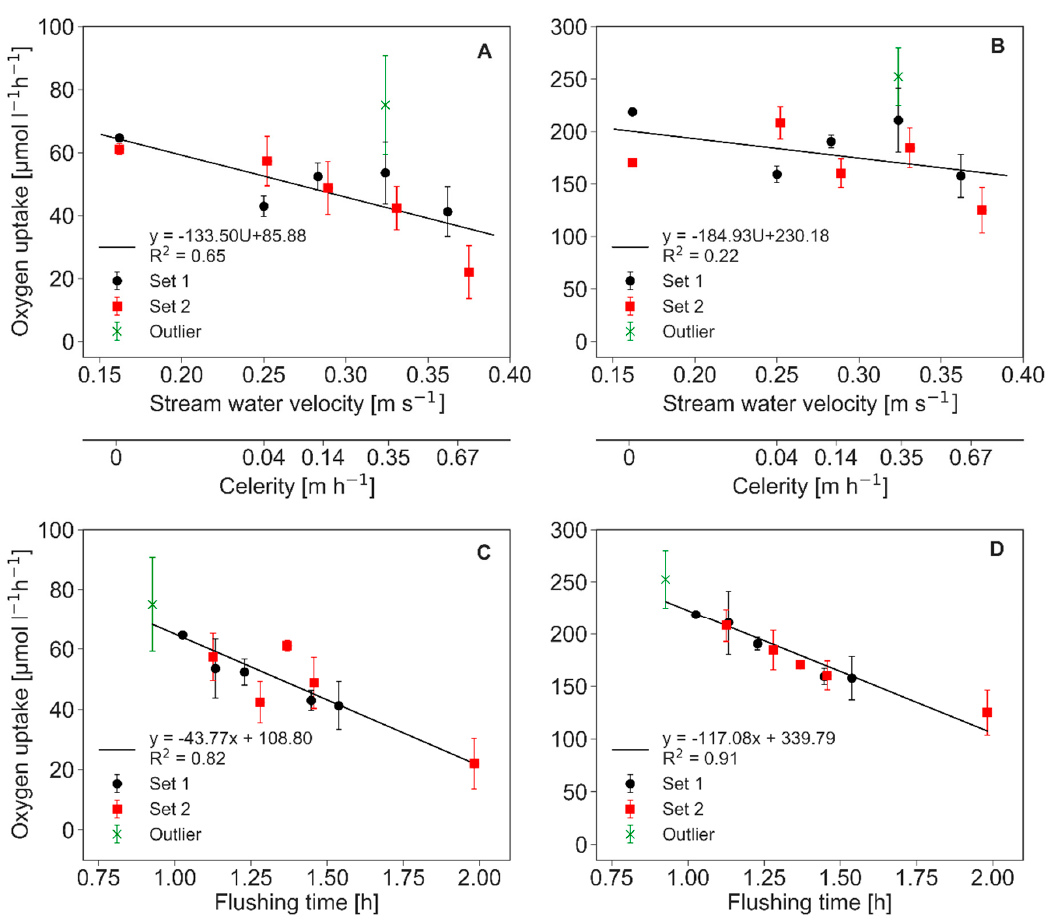
Figure 5. Oxygen uptake rates under different stream water velocities, bed form celerities, and flushing times of the oxygenated zone. The delta method ( A ) and ( C ) is based on the assumption that a proportion of oxygen in the hyporheic zone is transported back to the surface water. The maximum uptake method ( B ) and ( D ) is based on the assumption that all oxygen transported into the subsurface is consumed. The standard deviations are shown as error bars.